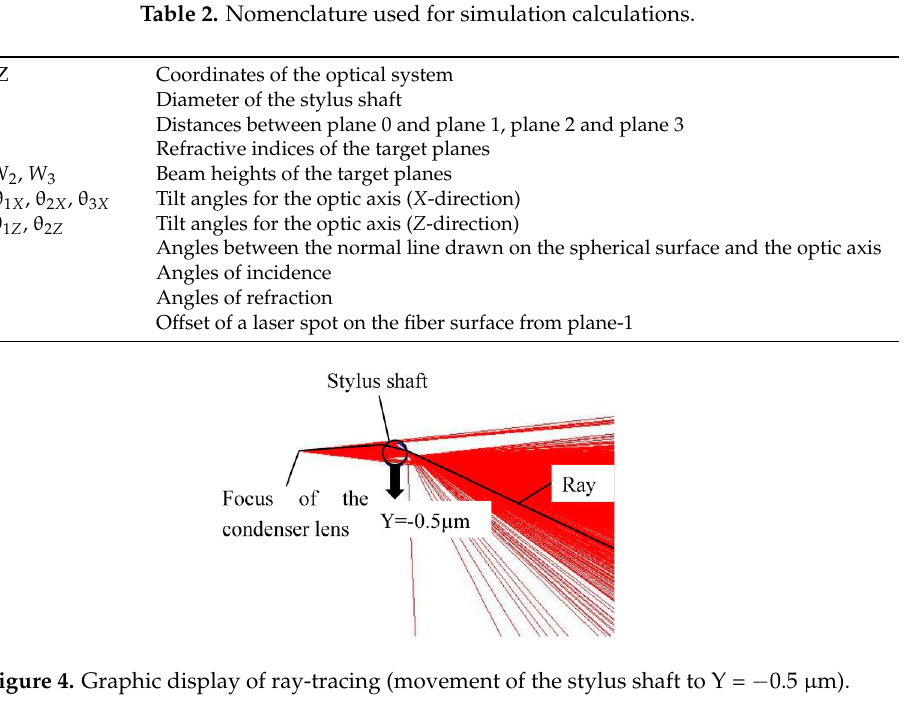
Figure 6. Photograph of the fiber stylus. 3.3. Simulation Results Figures 7 and 8 show the ray-tracing simulation results for the case where the stylus shaft is displaced from −7 to +7 µm in the X direction. L 0 is selected such that all rays intersect with the stylus shaft. Figure 7 shows the simulation result of I Y for distances L 1 = 40, 80, and 120 mm. Since I Y changes only slightly, the sensitivity relative to the X direction is low. Figure 8 shows the simulation results of I X for distances L 1 = 40, 80, and 120 mm under the same conditions. The rate of change of I X is maximum for L 1 = 40 and 80 mm. The slope of the curve for L 1 = 120 mm is gradual, resulting in low resolution. The resolution and the measuring range change as a function of the diameter of the stylus shaft. Therefore, the design parameters must be determined as functions of the system specifications.